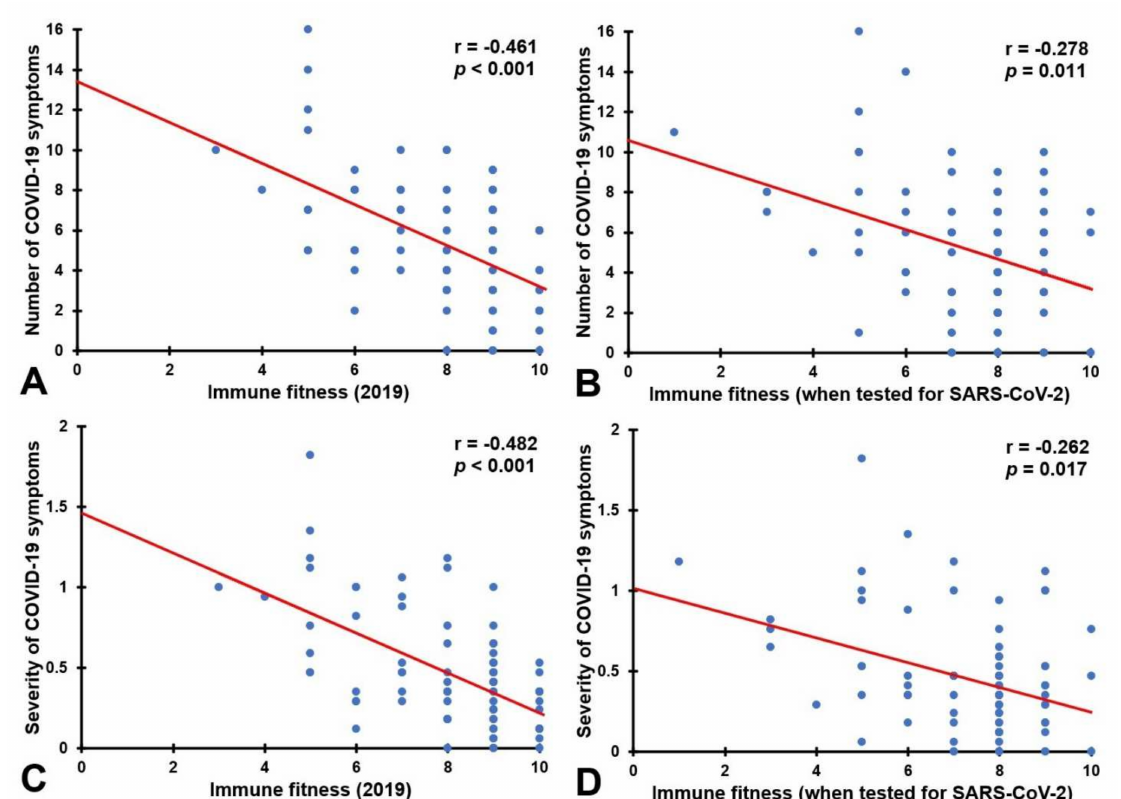
Figure 1. Relationship between immune fitness and the number and severity of COVID-19 symptoms for participants that tested positive for SARS-CoV-2. Shown is the relationship between the number of COVID-19 symptoms and immune fitness (2019) ( A ) and immune when tested for SARS-CoV-2 ( B ), and the relationship between the severity of COVID-19 symptoms and immune fitness (2019) ( C ) and immune fitness when tested for SARS-CoV-2 ( D ). The red lines represent the Spearman’s correlations. Correlations are considered significant if p < 0.05. Abbreviations: COVID-19 = coronavirus disease 2019; SARS-CoV-2 = severe acute respiratory syndrome coronavirus